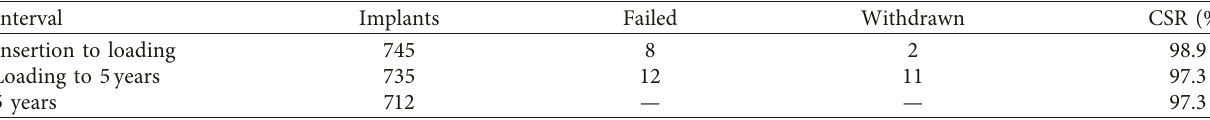
Table 6: Implant survival.